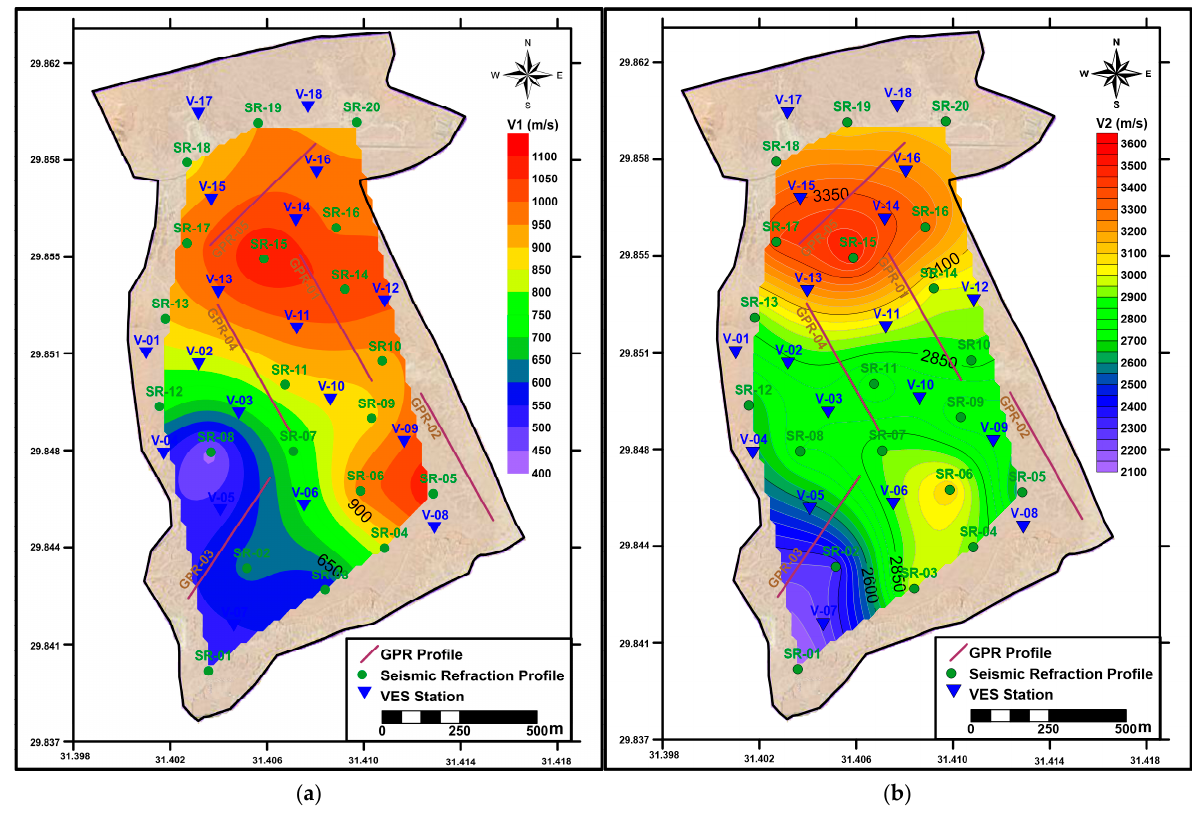
Figure 9. Seismic velocity contour map of ( a ) surface layer and ( b ) second layer.